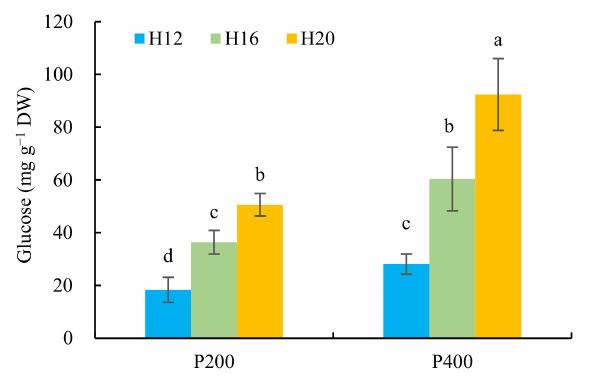
Figure 8. Effect of photosynthetic photon flux density (P) and photoperiod (H) on glucose content of cucumber seedlings at 21 days after sowing (DAS) in a closed transplant production system. Data are presented as mean ± standard deviation. Different letters indicate significant differences at p <